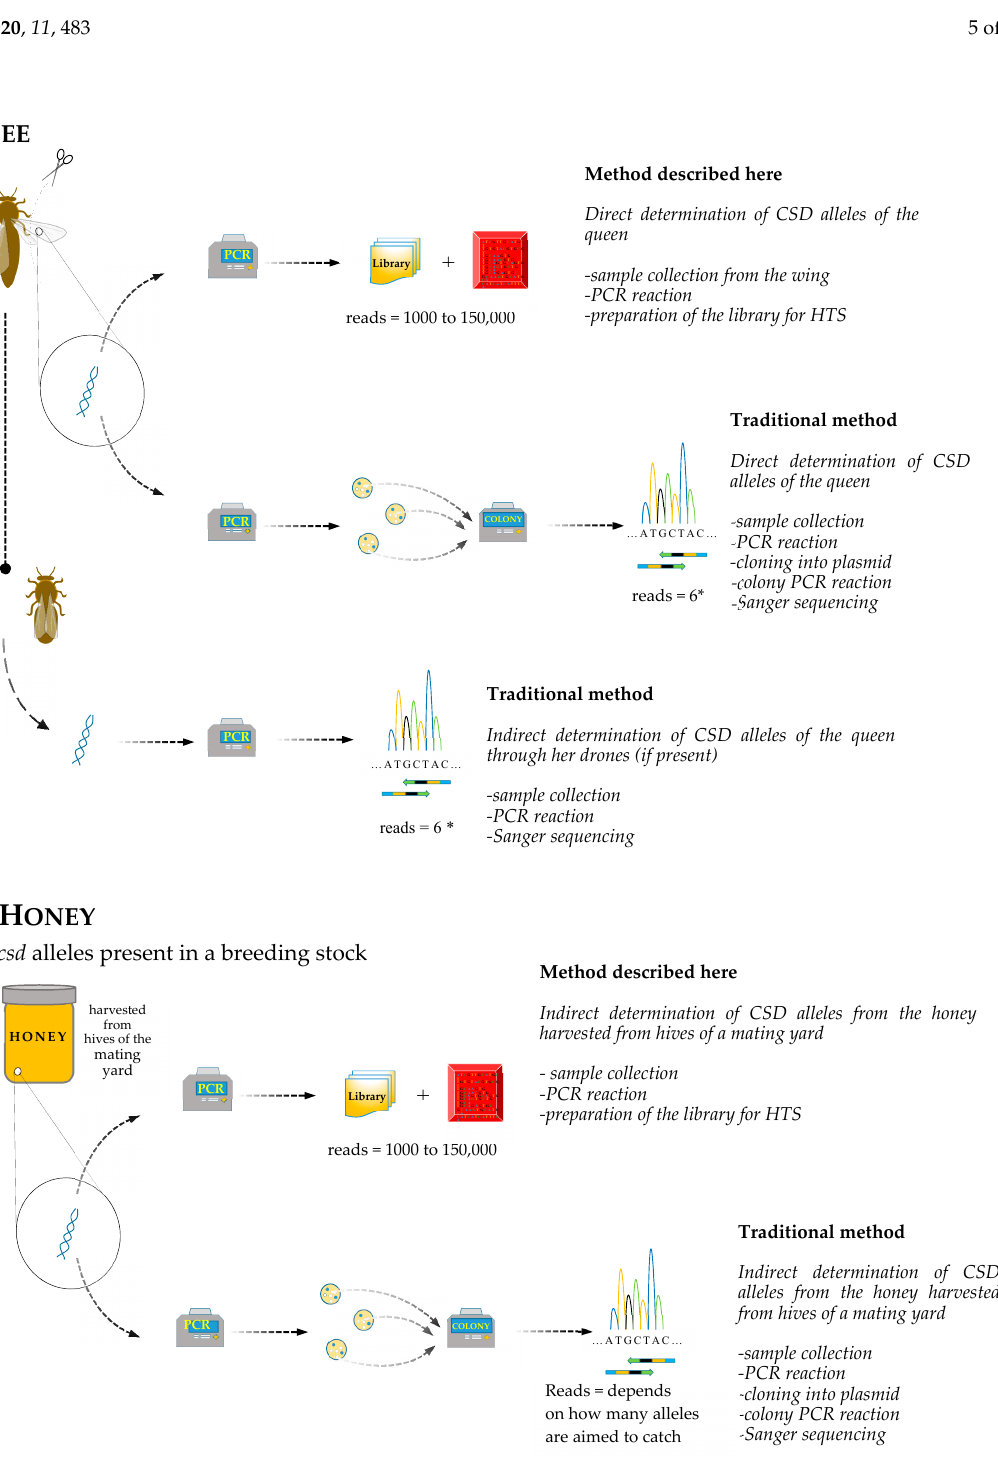
Figure 1. Comparison of the two methods shows that traditional methods provides alternative only when drones are available with a compromise of more DNA extraction and PCR. However, if queen is directly targeted, it leads to extensive molecular cloning and sequencing. The advantage of the novel approach is disputable when investigating bulk samples.* In order to successfully catch both alleles, 6 sequencing is